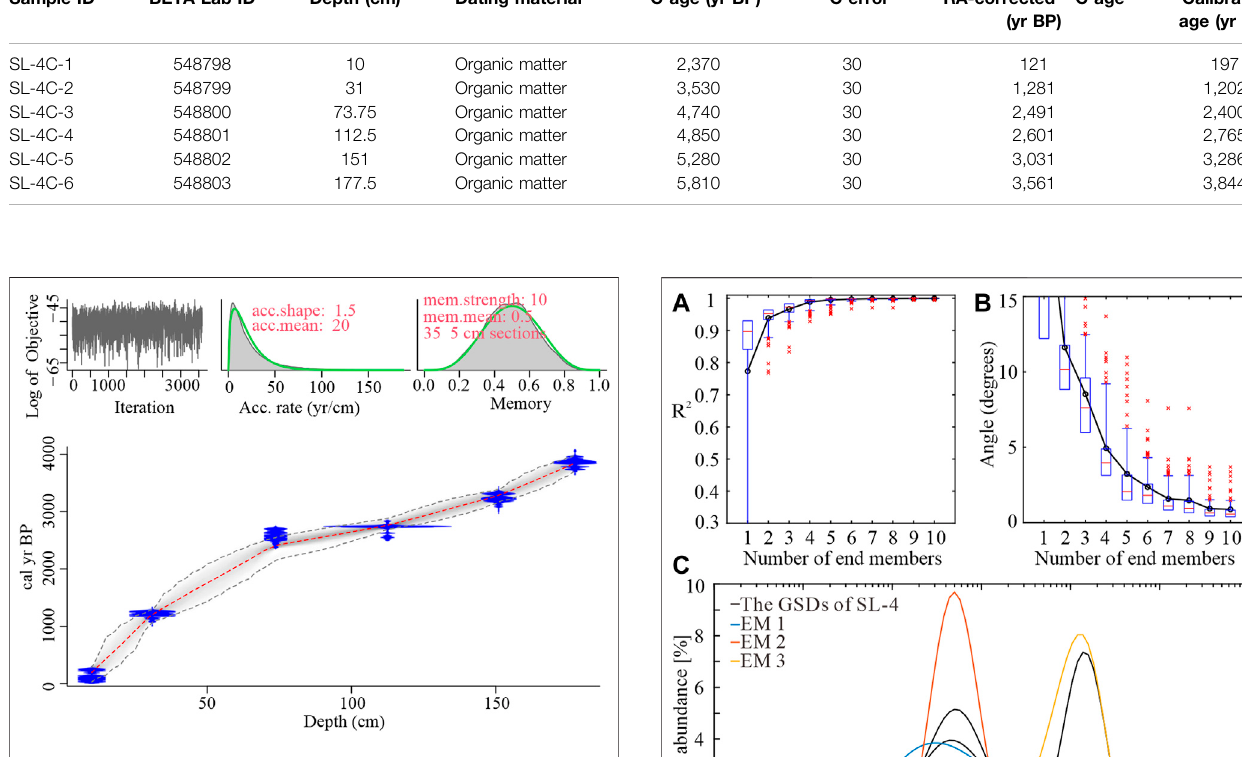
FIGURE 3 | Age – depth model for core SL-4. The blue area shows the probability density of the calibrated result for each radiocarbon date. The gray scaleindicatestheprobabilitydensityfunctionoftheage – depthmodeling.The red lines indicate the weighted mean ages, which were used for all curves throughout the study.